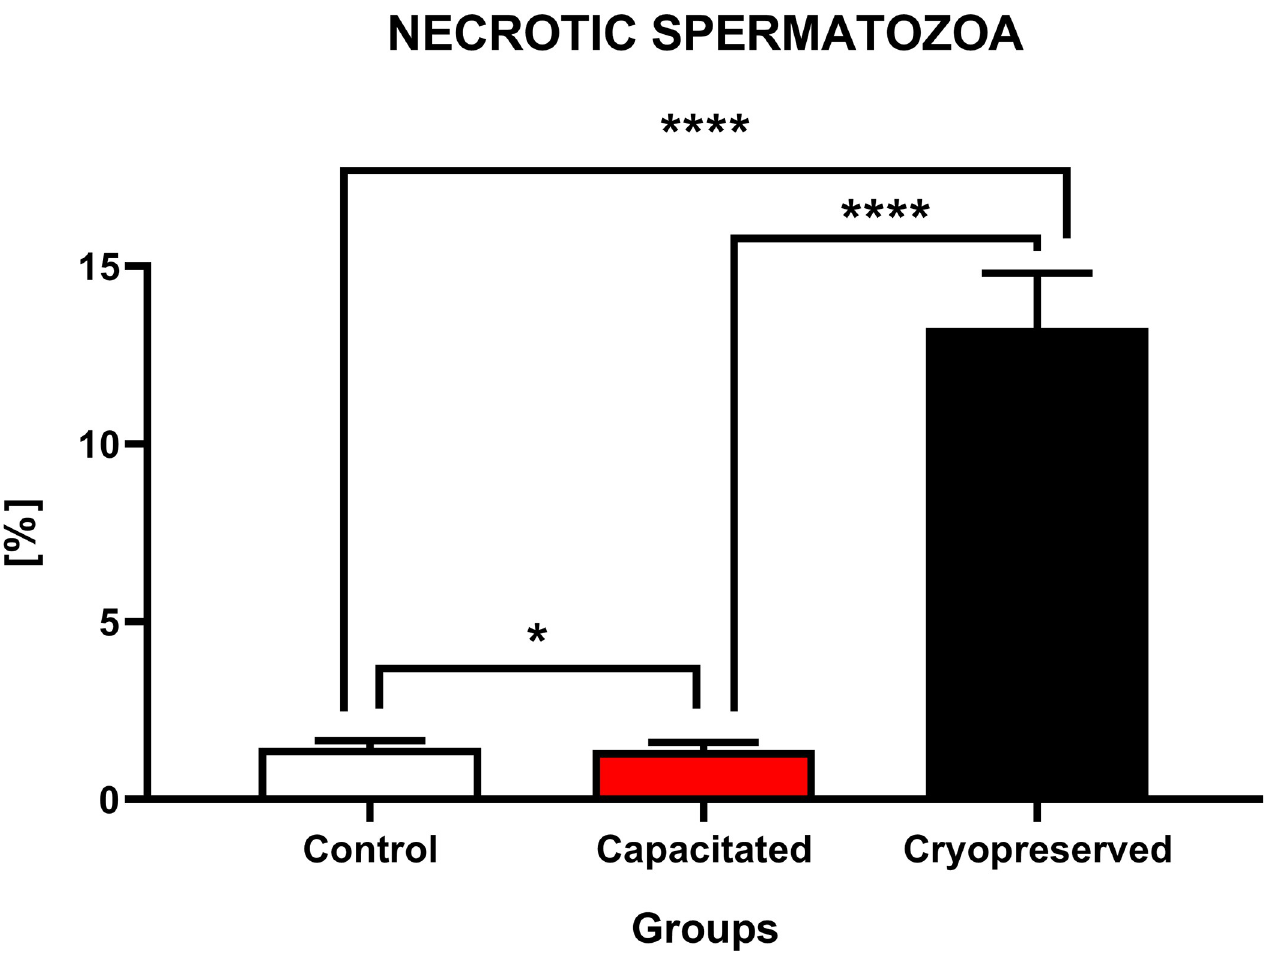
Fig 7. Occurrence of necrotic spermatozoa. The graph showed the level of cell necrosis (%) between the fractions of bull spermatozoa ( ± SD). The level of significance was set at � P < 0.05; �� P < 0.01; ��� P < 0.001; ���� P < 0.0001.